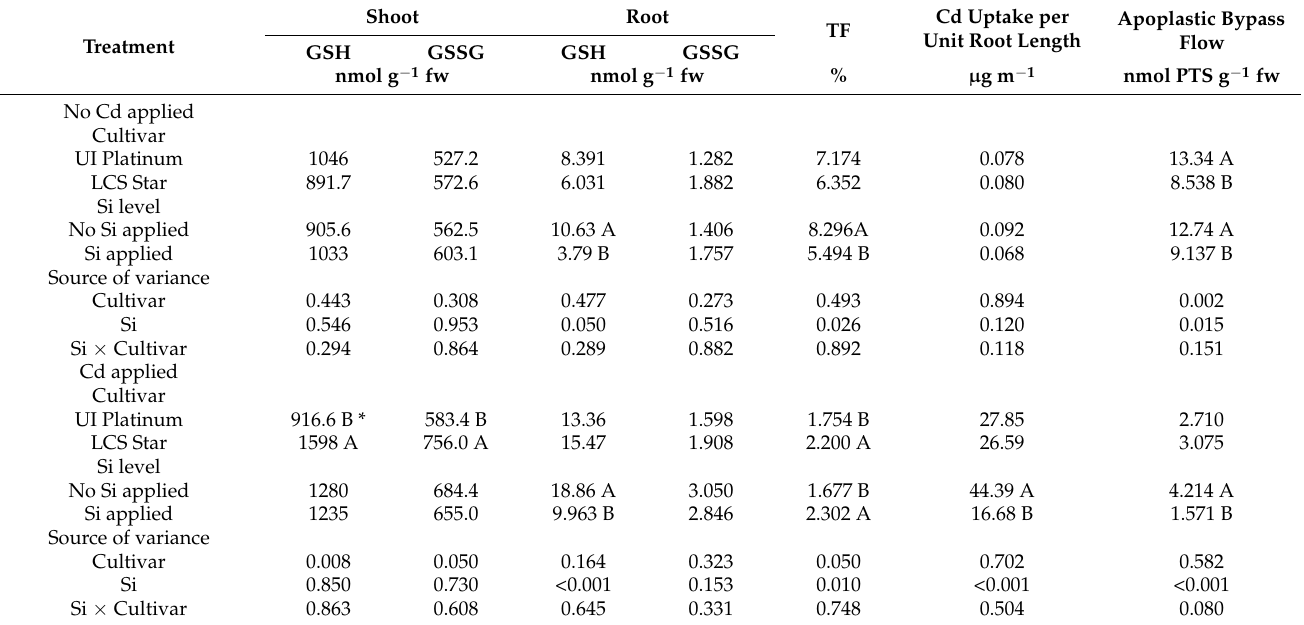
Table 2. Concentrations of glutathione (GSH) and glutathione disulfide (GSSG) in shoot and root, translocation factor (TF), Cd uptake per unit root length, and apoplastic bypass flow affected by Si level and cultivar without and with Cd